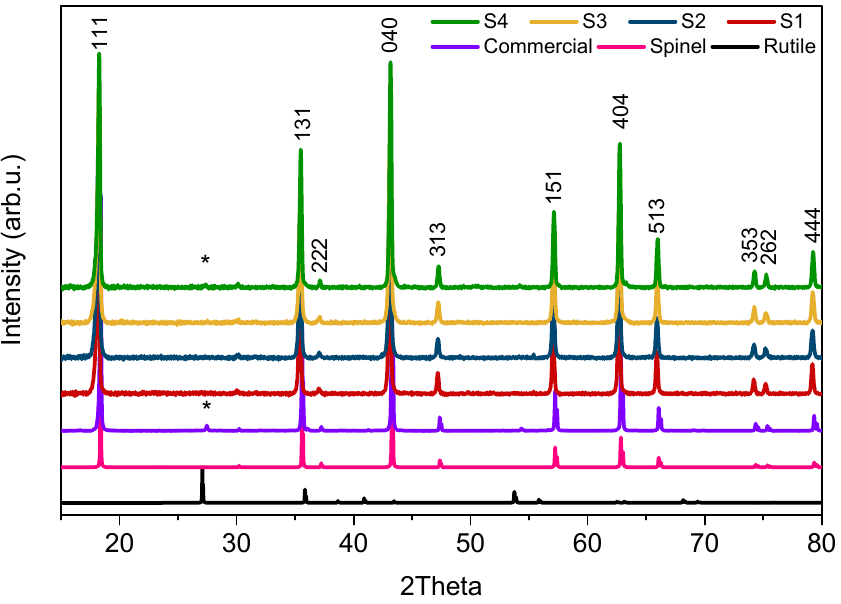
Figure 2. XRD patterns of sol–gel synthesized LTO and the commercial sample and the theoretical patterns of rutile and spinel structures (* TiO 2 phase marked in samples diffractograms). Table 1. Crystallite sizes and lattice parameters for pristine sol–gel and commercial LTO samples. R—rutile.